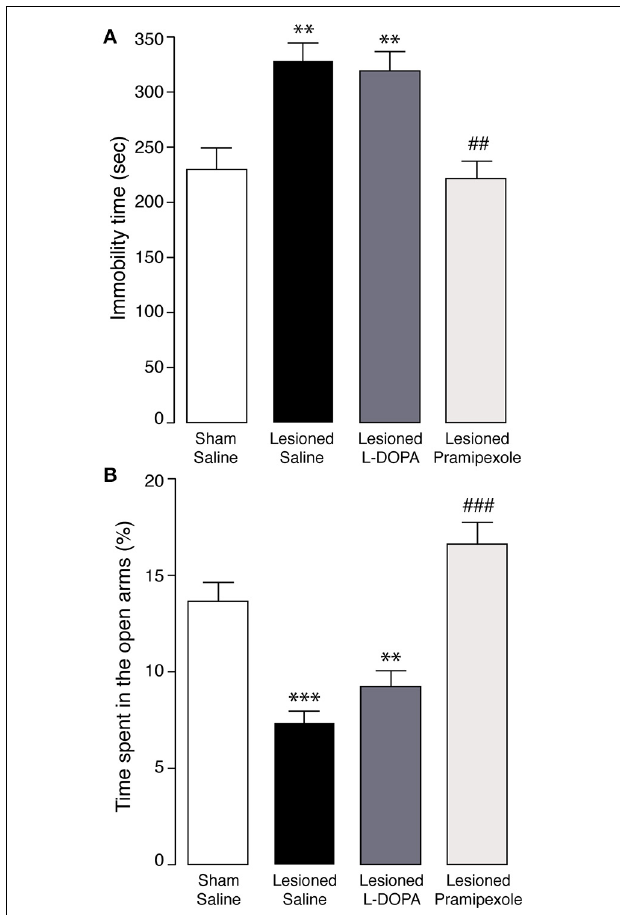
FIGURE 6 | Effect of noradrenaline reuptake inhibitors on anxiety- and depression-like behaviors induced by 6-OHDA. Sham, and 6-OHDA-lesioned mice treated for 4 days with saline, or reboxetine (20mg/kg). An additional group of mice (red) was pretreated with desipramine (25mg/kg) prior to lesion with 6-OHDA. Bar graphs show the immobility time (s) during the forced swim test ( A ; test duration, 10min) and the time spent in the open arms (% of the test duration) during the elevated plus maze test ( B ; test duration 5min). Data are expressed as mean ± s.e.m. ( n = 7 − 21) . ∗∗ p < 0 . 01 , ∗∗∗ p < 0 . 0001, vs. sham mice, ## p < 0 . 01 , ### p < 0 . 0001 vs. 6-OHDA-lesioned mice treated with saline, One-Way ANOVA, followed by Fisher post-hoc